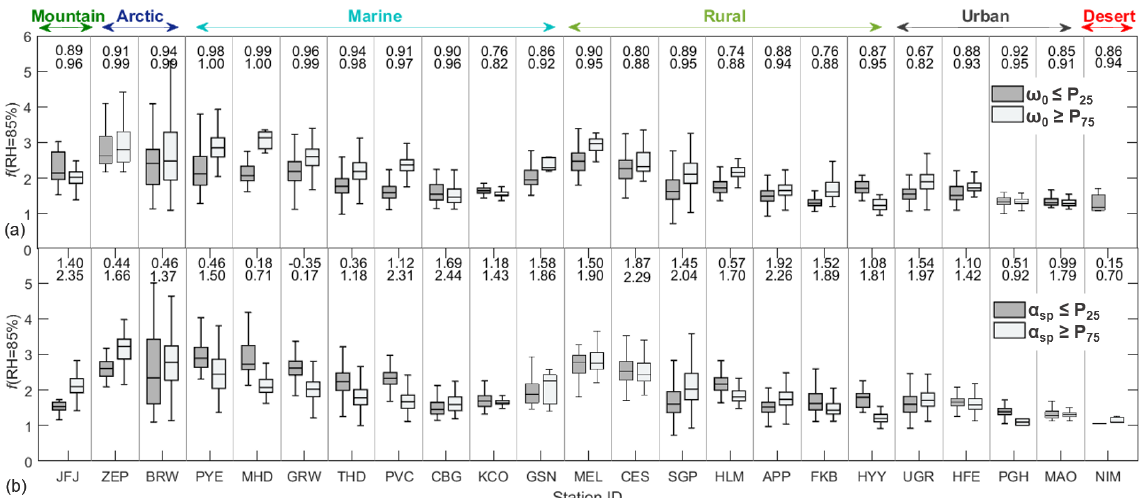
Figure 6. Box plot of f (RH = 85%) at 550nm ( λ = 525nm at HYY) segregated by single-scattering albedo ( ω 0 ) values (a) and scattering Ångström exponent ( α sp ) values (b) . Sites are sorted by site type and decreasing f (RH = 85%). For each box, the central mark is the median, the box extends vertically between the 25th and 75th percentiles, and the whiskers extend to the most extreme data that are not considered outliers. The numbers on top indicate the 25th and 75th percentiles used for segregating each dataset. Categories that are not significantly different are shown with thinner lines in the box plot.